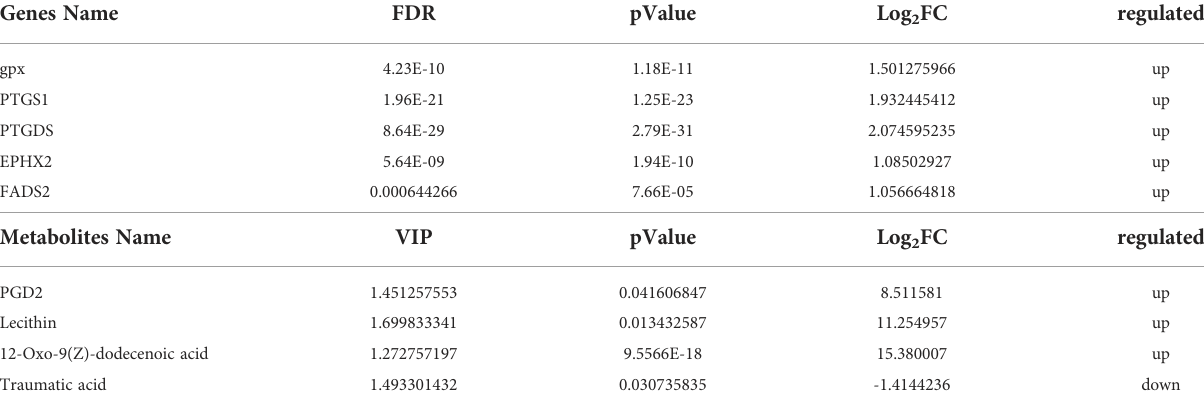
TABLE 2 Integrated analysis of DEGs and